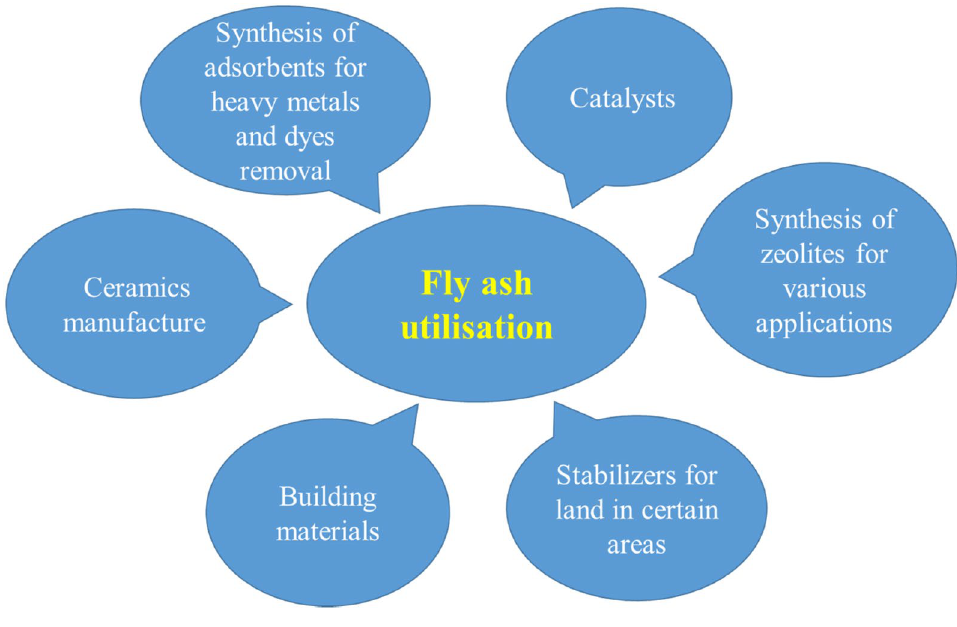
Figure 1. Fly ash